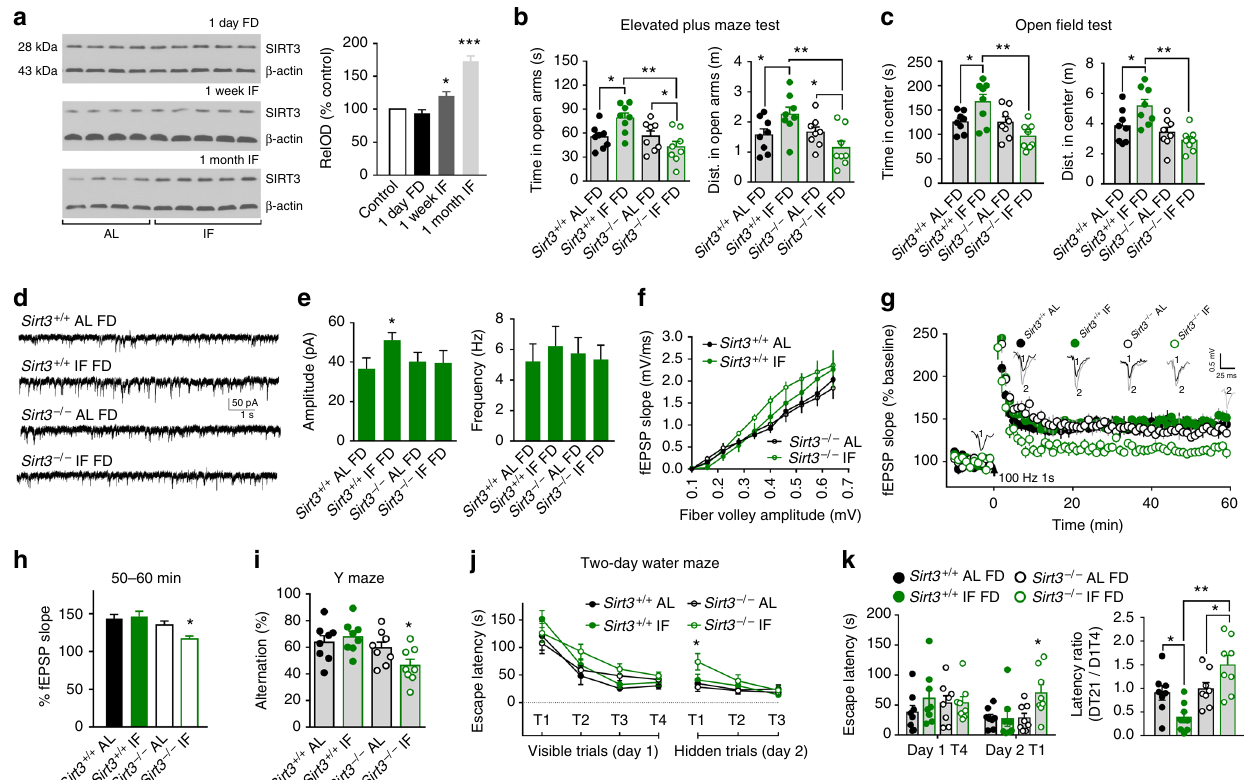
Fig. 2 SIRT3 is required for behavioral and synaptic adaptations to IF. a Immunoblots show relative levels of SIRT3 protein in hippocampus of mice that had were either fed AL or maintained on alternate day food deprivation (IF) for 1 week or 1 month. The upper blot is samples from mice killed on the second day after diet initiation (at the end of the fi rst 24 h FD period for mice in the IF group). * P < 0.05, *** P < 0.001 compared to the AL NFD and 24 h FD groups (11 mice/group). b, c Time spent (left) and distance traveled (right) in the open arms of the elevated maze ( b ) and in the center zone of the open fi eld ( c ) for mice that had either been fed AL or IF for 1 month (12 mice/group). All tests were performed in mice that had been deprived of food for 24 h (FD). * P < 0.05. d Whole-cell recordings of mIPSCs in CA1 neurons in hippocampal slices from mice in the four indicated groups. e mIPSC amplitudes (left) and frequencies (right) of mIPSCs (15 neurons in slices from 5 mice/group). * P < 0.05. f – h fEPSP recordings at CA1 synapses in hippocampal slices from Sirt3 + / + and Sirt3 – / – mice that had been maintained for 4 months on either AL or IF diets. f shows basal synaptic transmission with the amplitude of the fi ber volley plotted against fEPSP slopes (input/output curves). g shows the results of LTP analysis. Panel h shows quanti fi cation of LTP magnitude. * P < 0.01 compared to the values for each of other three groups (10 slices from 5 mice/group). i Results of Y-maze testing. j , k Results of water maze testing. Group difference, F (3, 27) = 3.762, P = 0.022. k shows data for escape latencies on testing day 1 trial 4, and testing day 2 trial 1 (left), and latency ratios (escape latency on day 2 trial 1 divided by the escape latency on day 1 trial 4) (right). 8 mice per group, * P < 0.05, ** P < 0.01. All error bars are the SEM. All statistical comparisons used ANOVA and Newman – Keuls post hoc tests. Source data are provided in supplemental Source Data fi